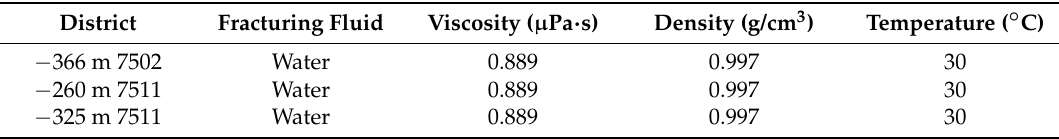
Table 2. Property of fracturing